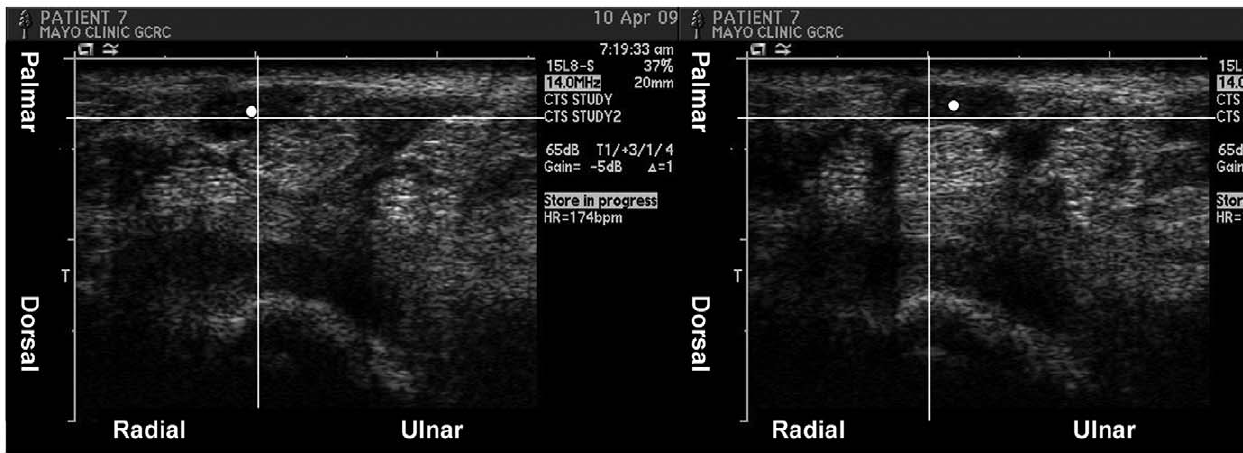
Figure 1. Example of median nerve motion direction measurement in middle finger motion in a patient. The centroid of the median nerve (white dot) was taken in extension (left picture) and flexion (right picture) to calculate motion direction. The grid shows the change in position of the median nerve centroid in ulnar-palmar direction.